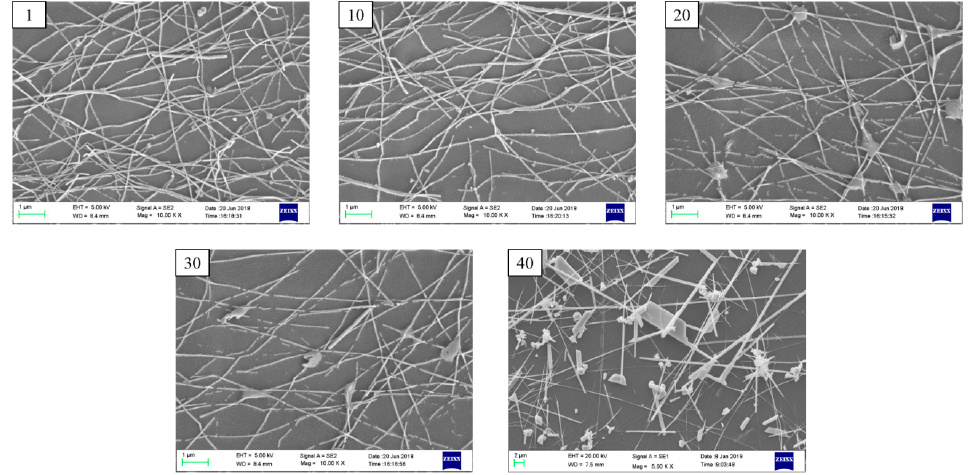
Figure 8. SEM images of the printed AgNWs patterns (2.0 mL silver nanowires ink) with di ff erent bending cycles (the numbers in the left upper corner).